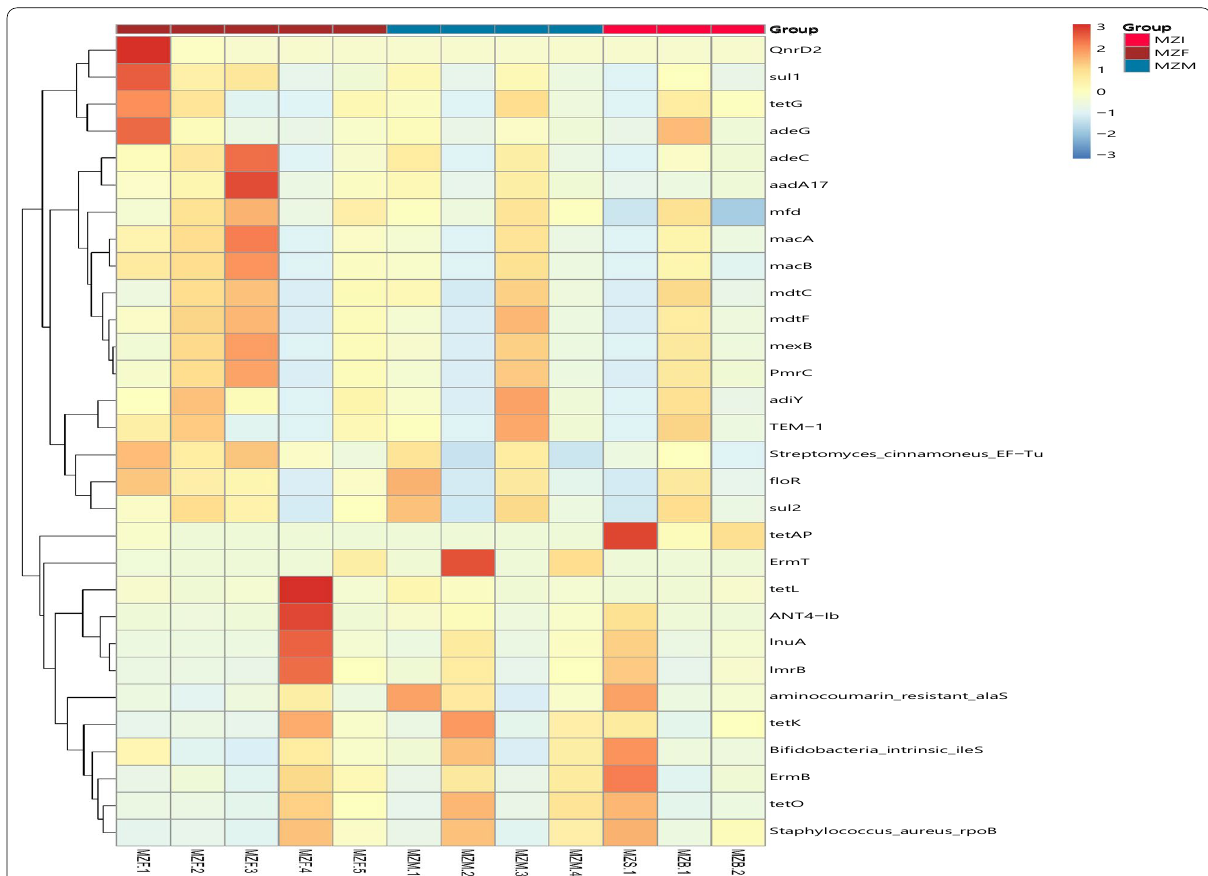
Fig. 10 ARO distribution and abundance cluster heat map. The right vertical axis is the ARO name, and the left vertical axis is the ARO cluster